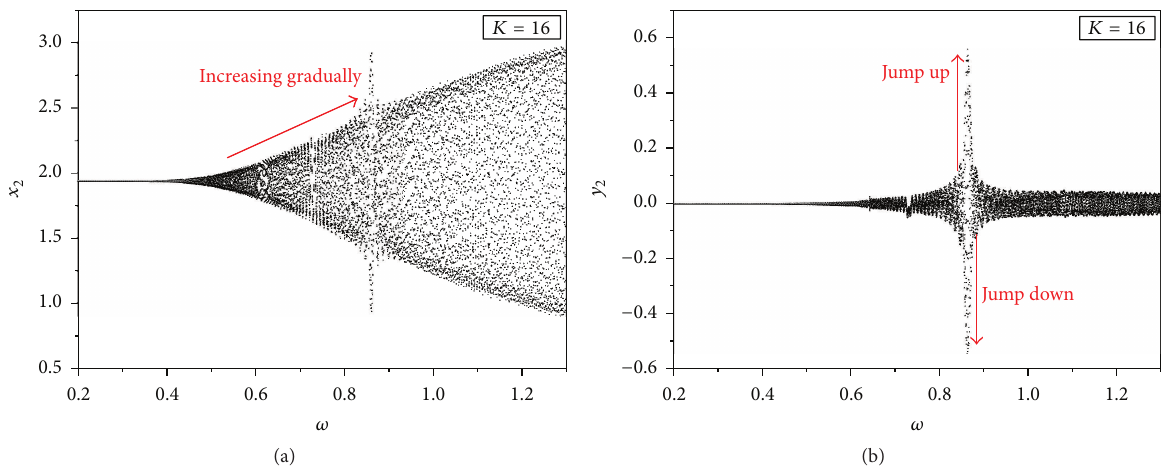
Figure 21: See 𝐾 = 16 . (a) Displacement 𝑥 2 steady-state response. (b) Displacement 𝑦 2 steady-state